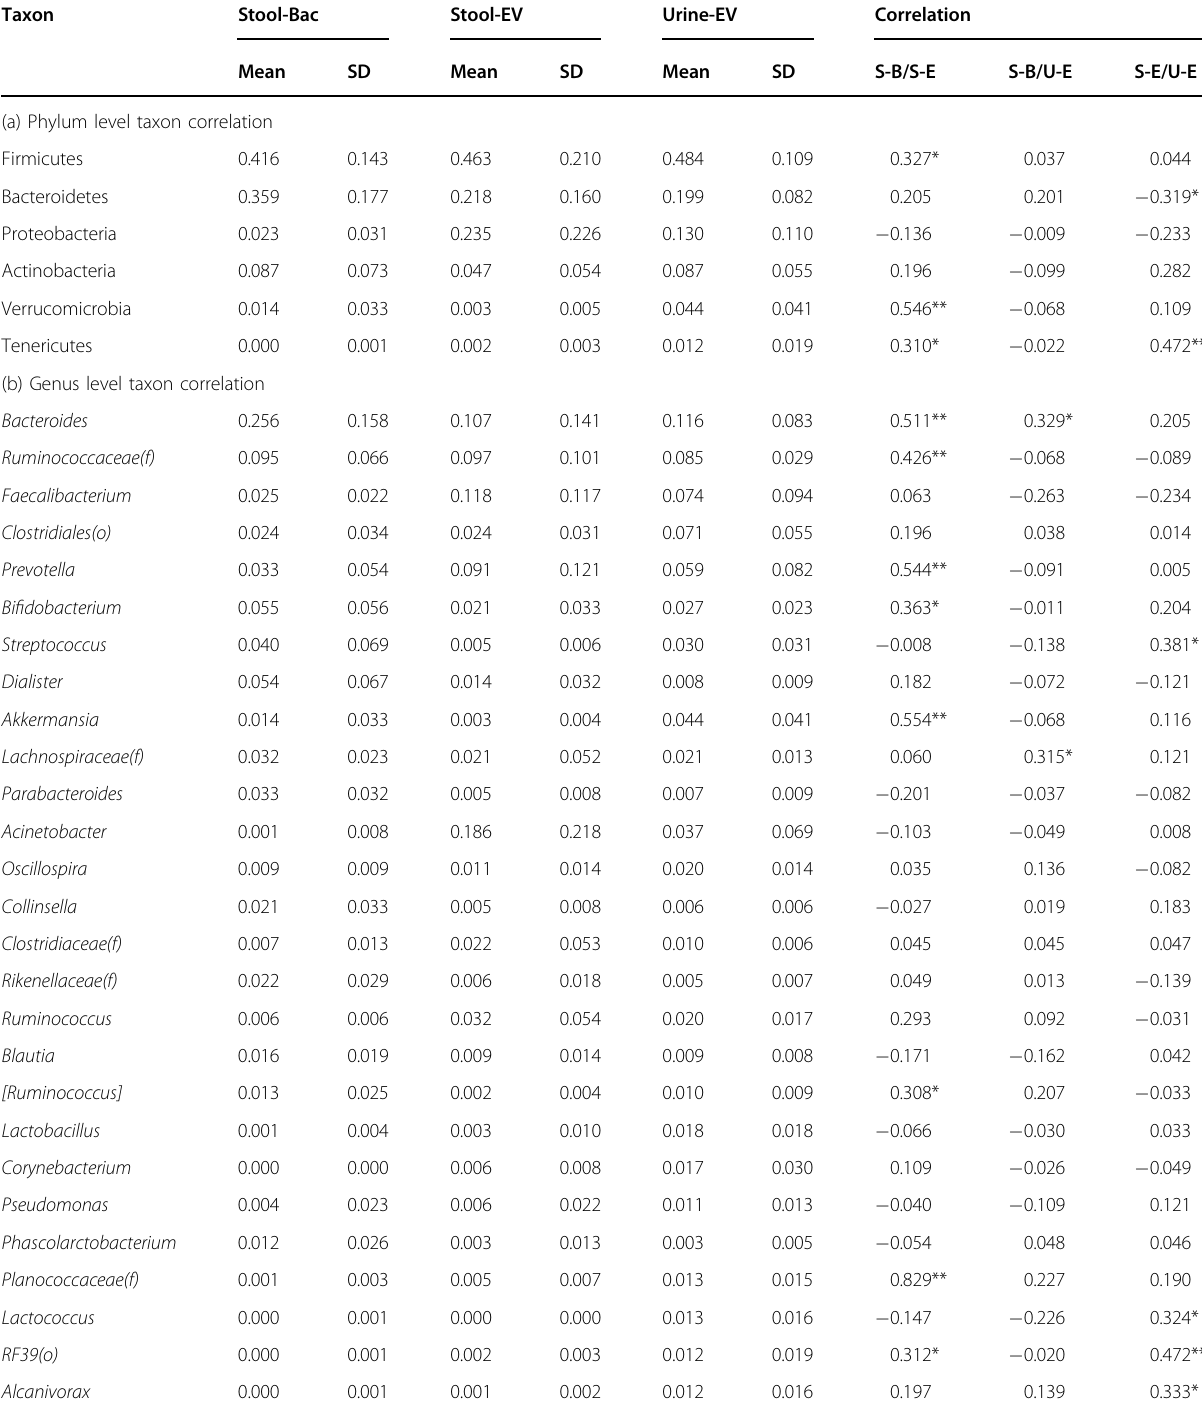
Table 3 Correlation between individual taxa of each sample